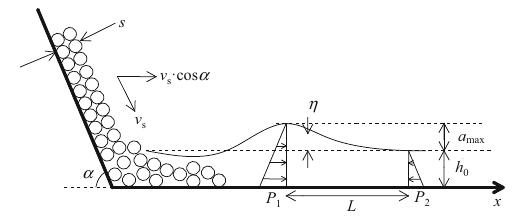
Fig. 1 Schematic of the interaction between the fluid structure of the granular material and the water. s landslide thickness; a inclusion angle of the slope with the horizontal plane; v s velocity of granular material; g surge amplitude of the surge; a max maximum amplitude of the surge; h 0 initial water depth; P 1 the position where the maximum amplitude is generated; P 2 the position unaffected by surge; L the distance between P 1 and P 2 ; x the coordinate of surge